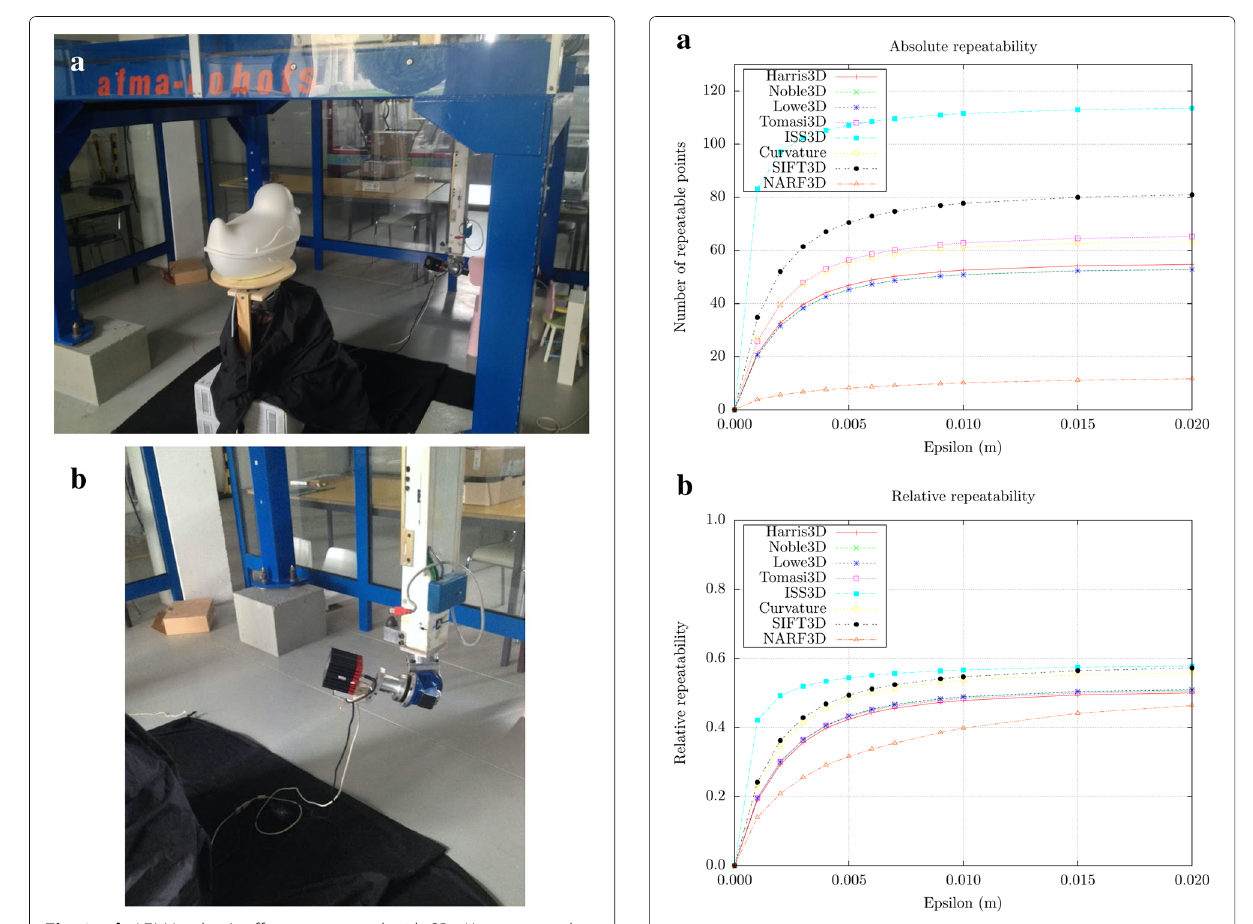
Fig. 10 a Absolute repeatability and b relative repeatability